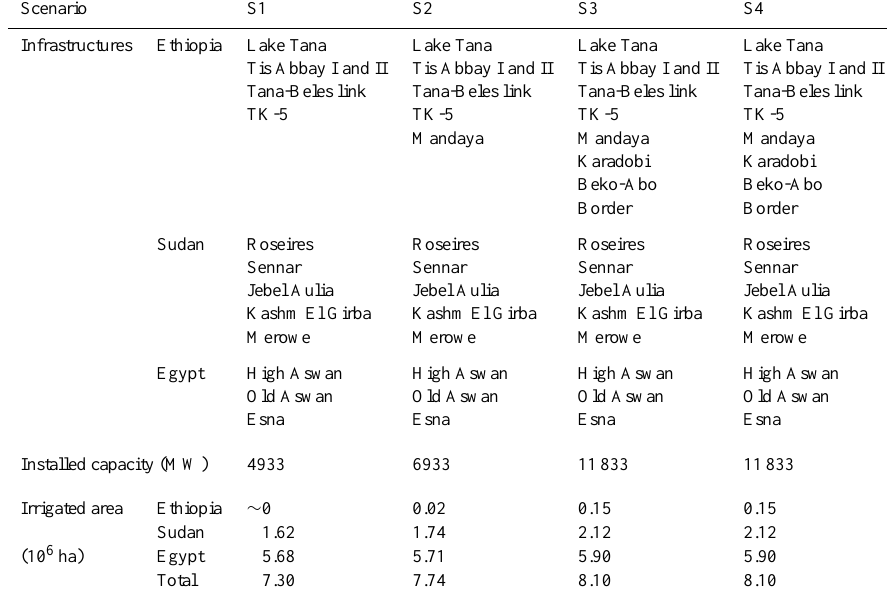
Table 2. Detailed description of the